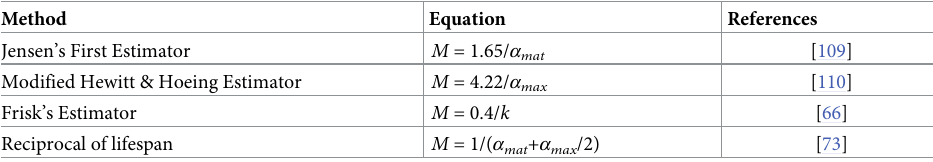
Maximum age ( α ) estimates were derived from a normal distribution using the mean and max S.D., calculated from the observed maximum age reported in the literature, minimum theoret- ical maximum age ( T ) and maximum theoretical age ( T ). As there was no current con- lower upper sensus on the best indirect method to estimate the instantaneous natural mortality, it was estimated using four common methods, Jensen’s First mortality estimate [109], modified Hewitt and Hoeing estimator [110], Frisk’s estimator [66], and reciprocal of the lifespan [67] (Table 3). Table 3. Natural mortality ( M ) methods used to estimate maximum intrinsic rate of population increase. Where α mat is age at maturity in years, α max is maximum age in years, and k is the von Bertalanffy growth coefficient in year -1 . Method Equation Jensen’s First Estimator M = 1.65/ α